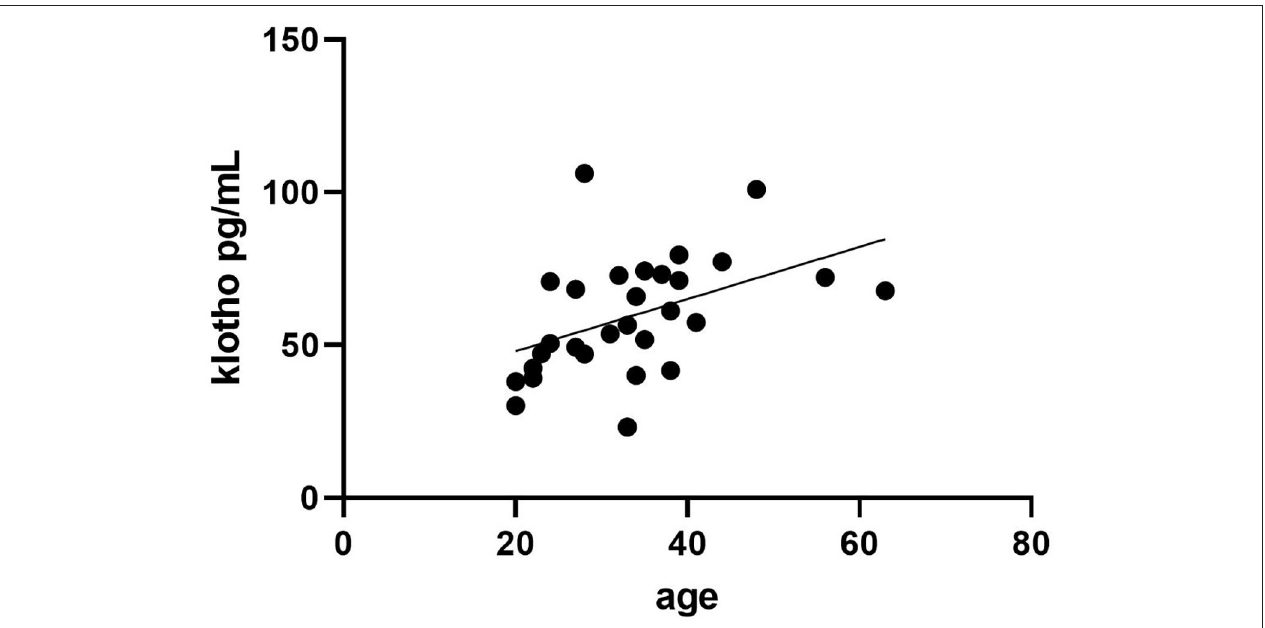
FIGURE 1 | Correlation between age (years) and klotho serum concentrations in 29 male individuals using anabolic androgenic steroids (AAS) within the last year.